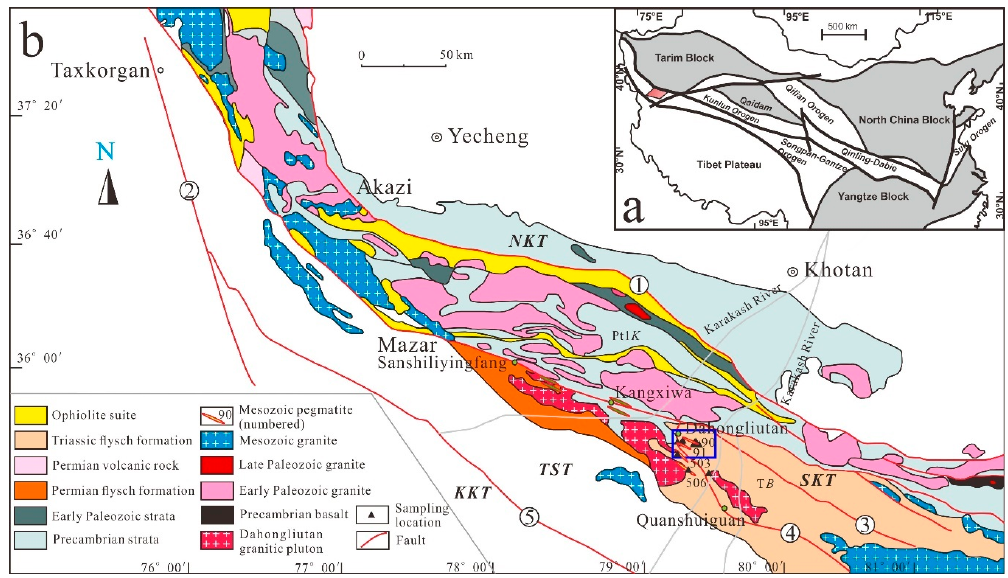
Figure 1. ( a ) Geological map showing the major tectonic units in China (after [36]) and the location of the study area (red quadrilateral) and ( b ) Geological map of the Western Kunlun Orogen (after [25,31]). Sutures and faults: 1-Oytag-Kudi Suture; 2-Karakorum Fault; 3-Mazha-Kangxiwa Suture; 4-